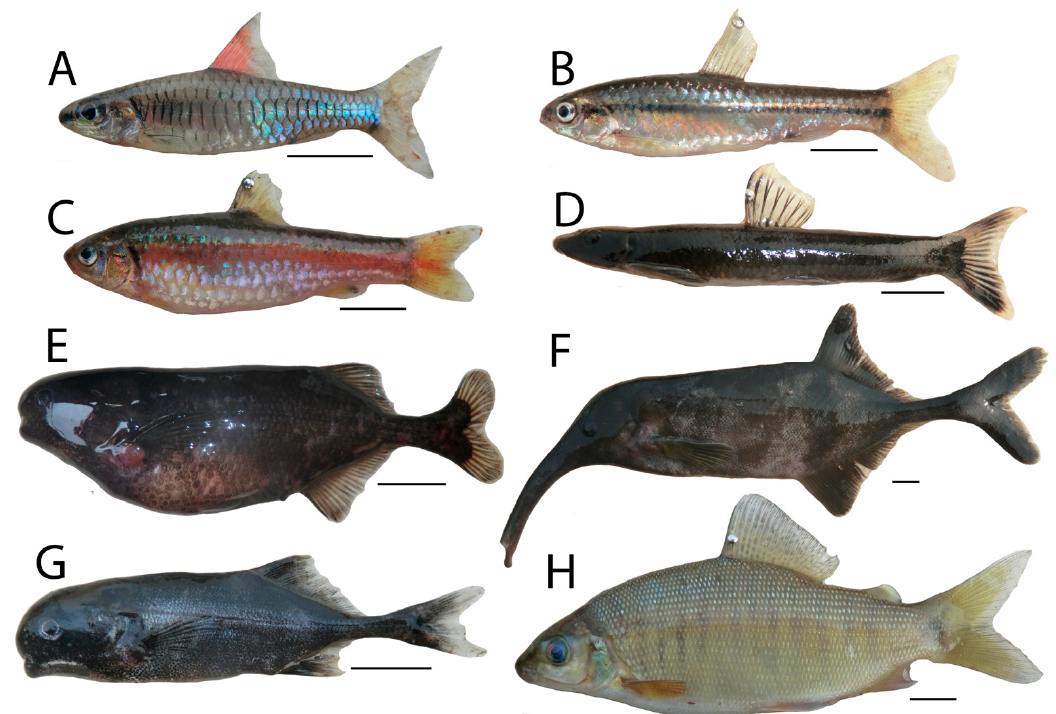
Figure A4. Selected species reported for the first time in the Kasai ecoregion: ( A ) Clypeobarbus mediosquamatus ; ( B ) Enteromius thamalakanensis ; ( C ) Enteromius sp. “purple stripe”; ( D ) Garra cf. congoensis ; ( E ) Pollimyrus castelnaui ; ( F ) Campylomormyrus curvirostris ; ( G ) Cyphomyrus cubangoensis ; ( H ) Distichodus polli . Photographed immediately postmortem, scale = 1 cm.